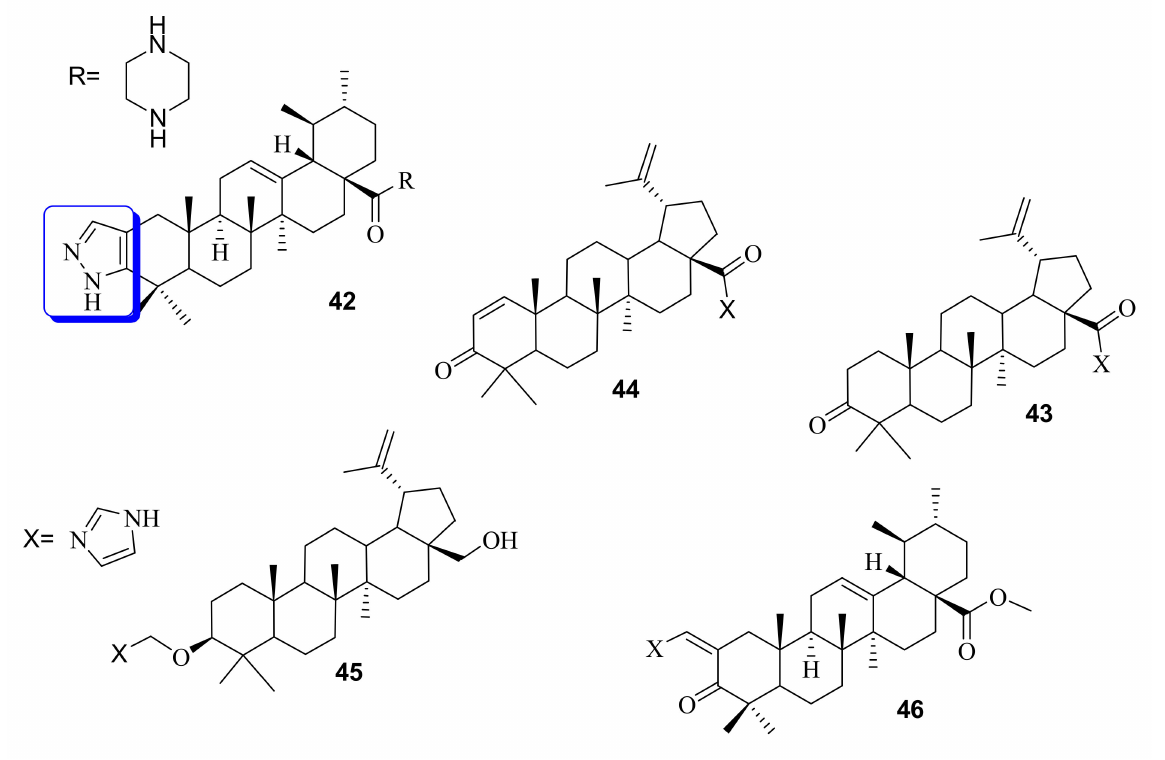
Figure 4. Ursolic acid and betulinic acid-base pyrazole